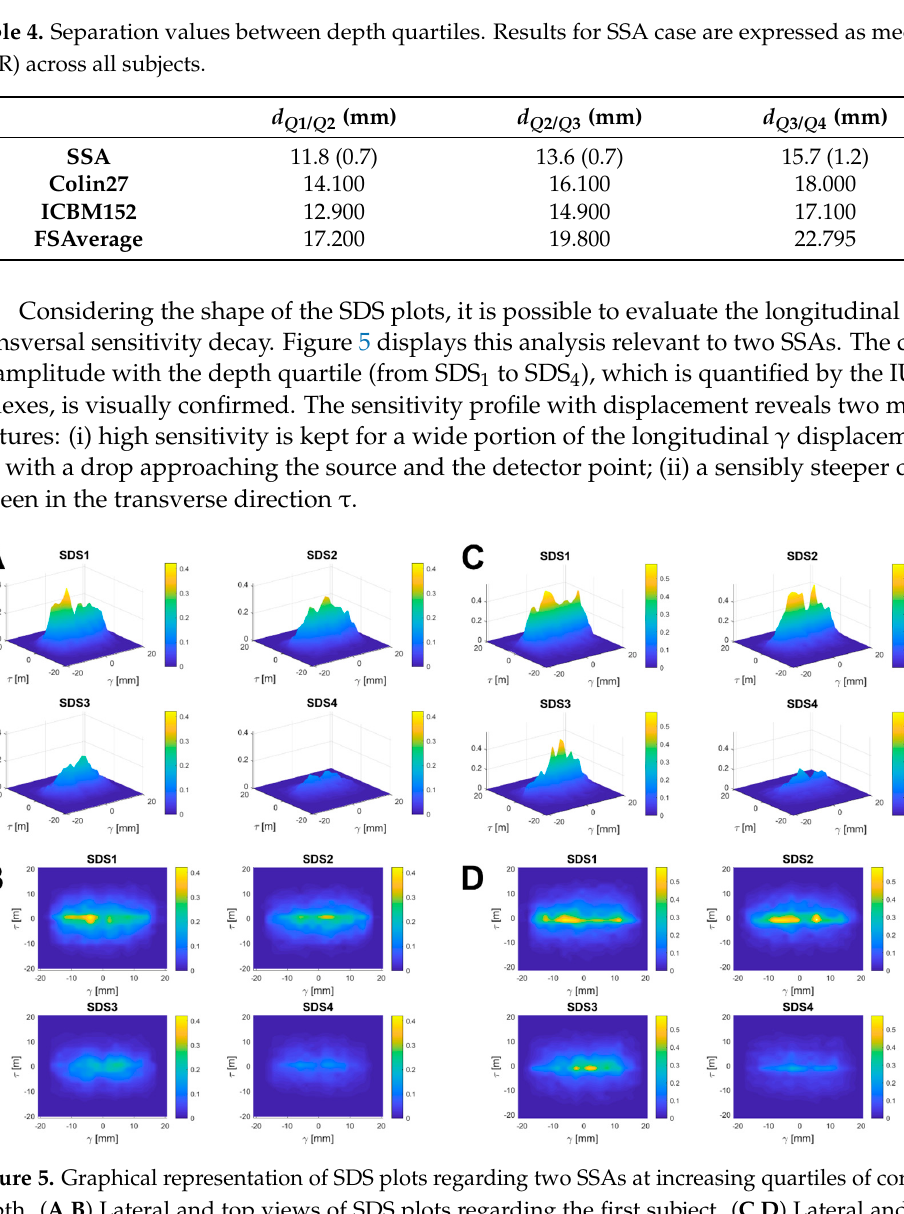
Table 4. Separation values between depth quartiles. Results for SSA case are expressed as median (IQR) across all subjects.